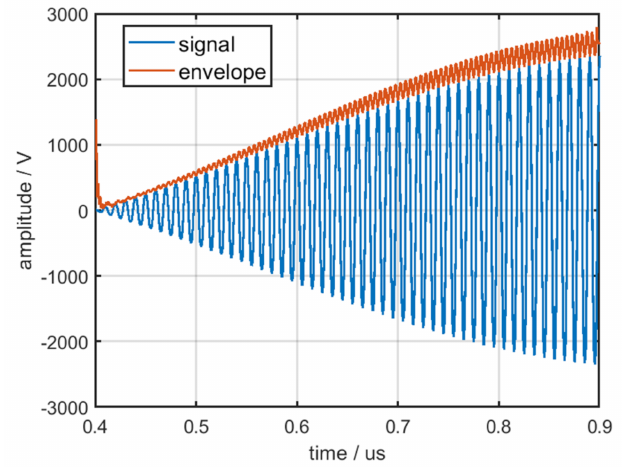
Figure 16. Envelope of the pulse front edge.